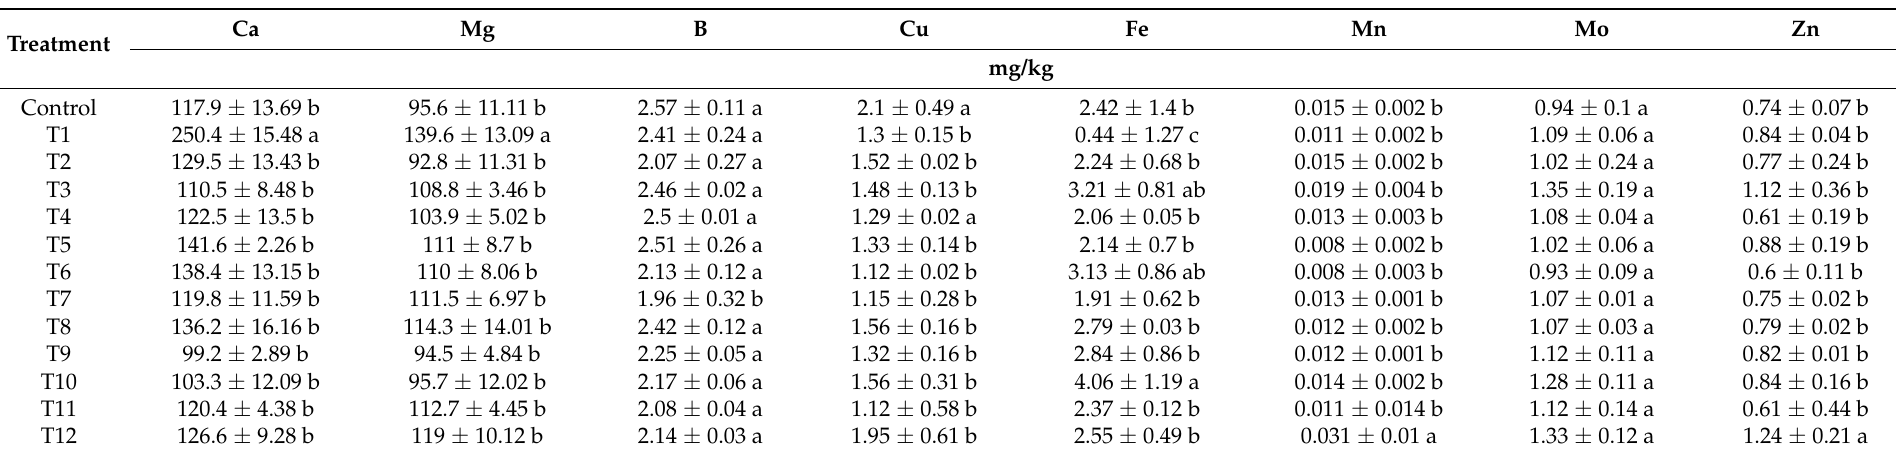
The same letters at the end of each column mean they are not significantly different by Dunnett’s test at p ≤